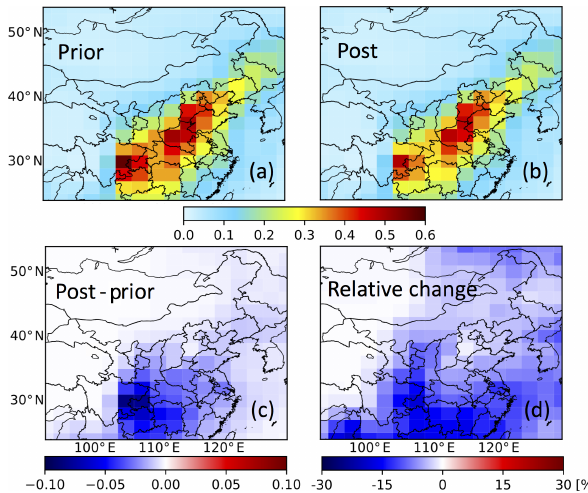
Figure 10. Relative change in GEOS-Chem SO 2 VCDs when NH 3 emissions reduce to 50% (a) and 20% (b) , respectively, at OMPS overpassing time. Panels (c) and (d) are similar to (a) and (b) , re- spectively, but for NO 2 .